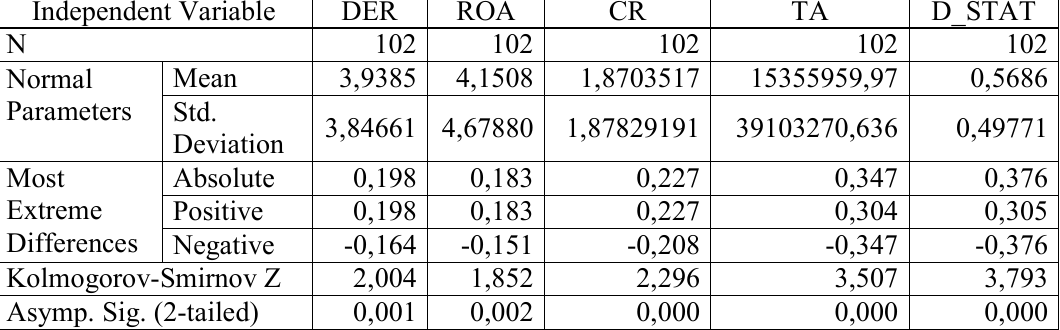
Tabel 6. Hasil Uji (cid:12)ormalitas dengan Kolmogorov Smirnov Independent Variable